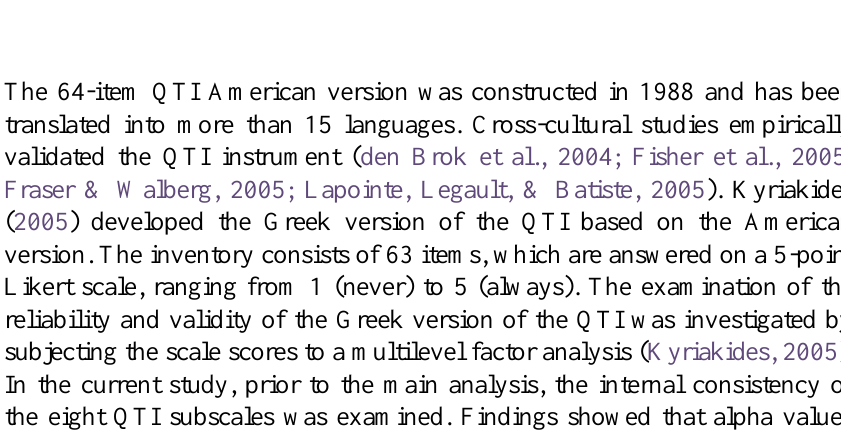
Figure 2. The Model for Interpersonal Teacher